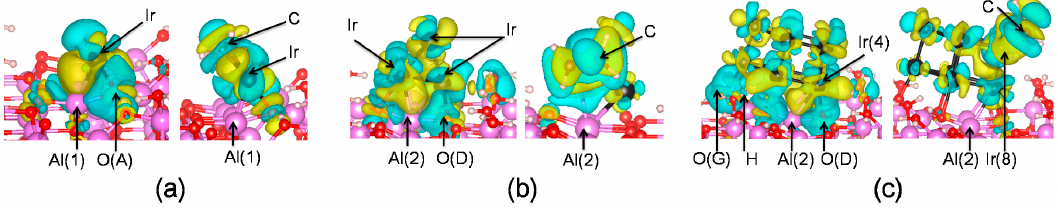
Figure 7. Electron density difference map for hydrated γ -Al 2 O 3 (110)-supported ( a ) Ir atom, ( b ) Ir 4 , and ( c ) Ir 10 systems. Left column: Ir n cluster adsorbed on γ -Al 2 O 3 ; right column: ethylene adsorbed on Ir n / γ -Al 2 O 3 . Depletion regions: blue; accumulation region: yellow.